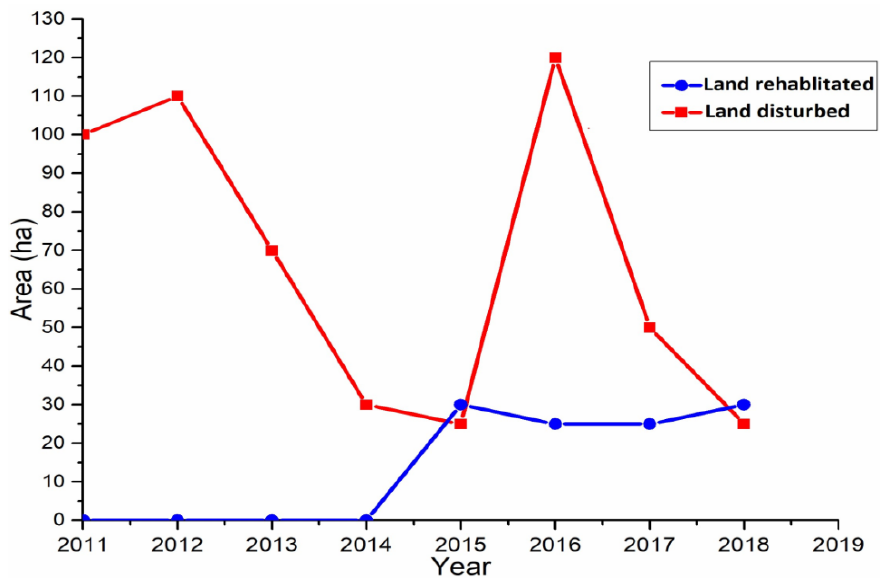
Figure 12. Land disturbance and rehabilitation in the district (based on data from the District EPA).